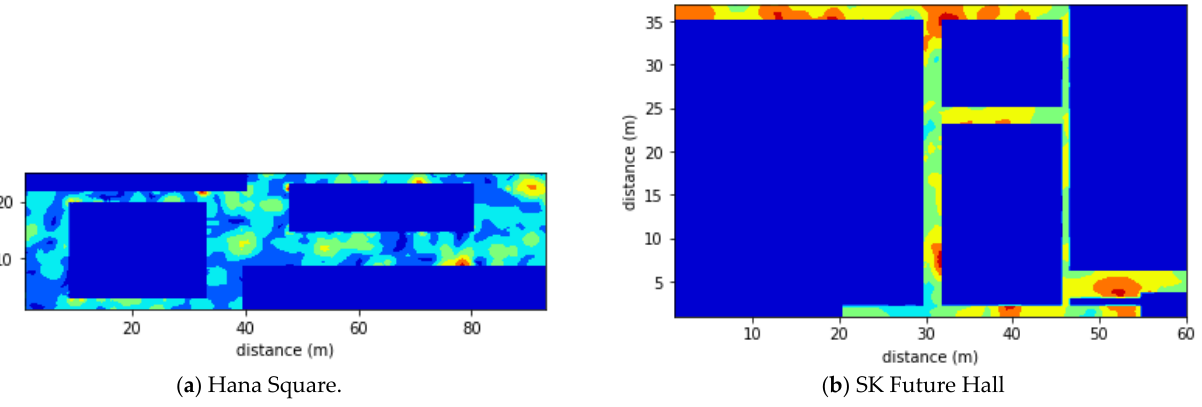
Figure 7. Geomagnetic field map of Hana Square.